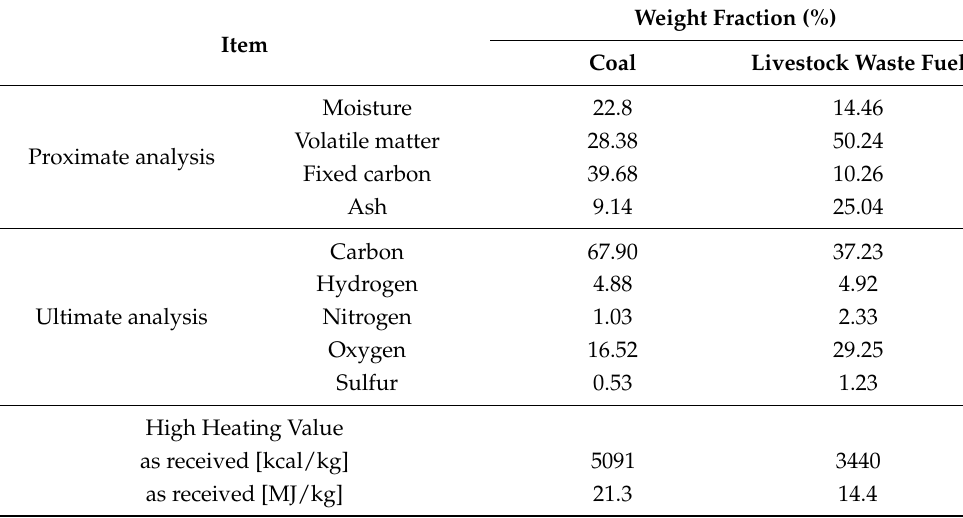
Table 1. Properties of coal and livestock waste fuel.